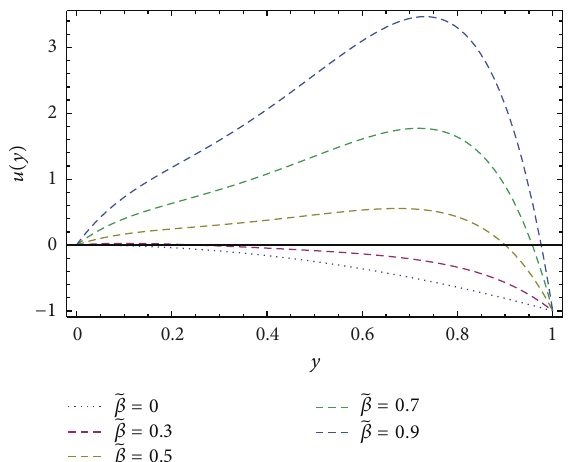
Figure 3: Profile of the nondimensional velocity 𝑤(𝑦) for different ̃ 𝛽 values of , keeping 𝑃 ,𝑥 = −2.0 , 𝑃 ,𝑧 = −2.0 , and 𝜙 = 45 ∘ .